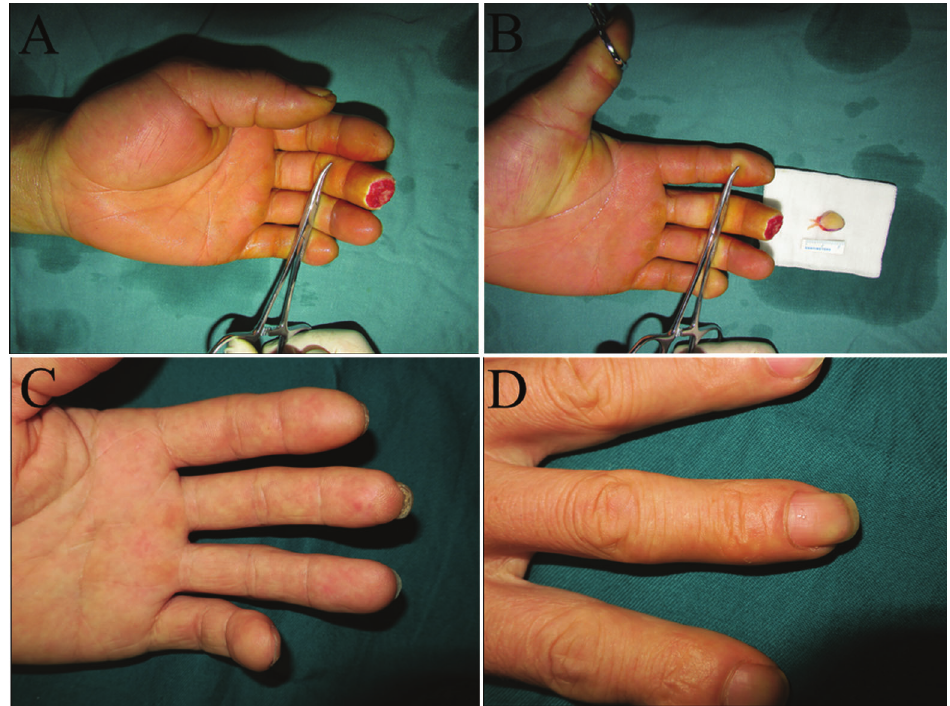
Figure 5 - In this patient, the injured fingertip after debridement (A), the flap before transplantation (B), and the volar (C) and dorsal (D) appearances after 9 months.